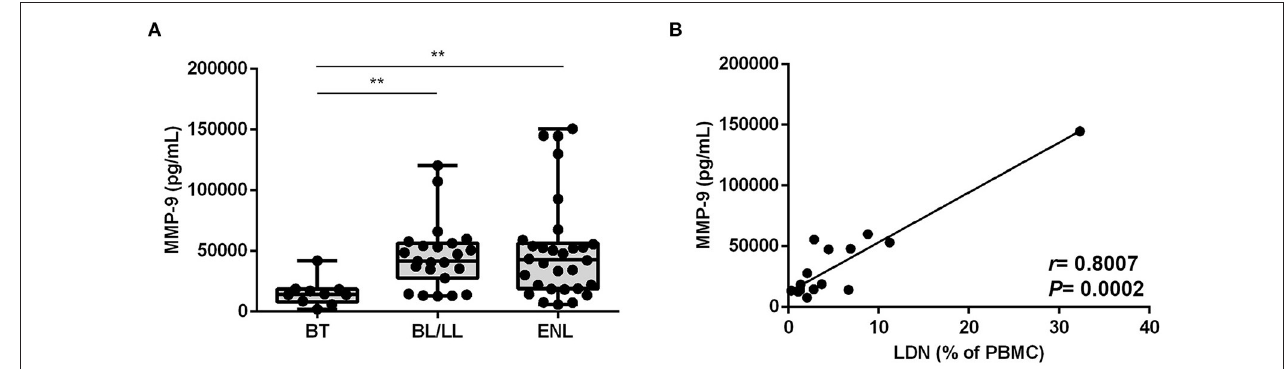
FIGURE 6 | MMP-9 degranulation correlates with the frequency of LDNs in BL/LL and ENL patients. (A) MMP-9 concentration was evaluated by enzyme-linked immunosorbent assay (ELISA) in the sera of 10 BT, 24 BL/LL, and 31 ENL patients. Box plots show median; interquartile range; and sample minimum and maximum. Dots represent individual patients. (B) Correlation between MMP-9 serum levels and frequency of circulating LDNs on BL/LL patients with or without ENL ( n = 17). Statistic: (A) Kruskal–Wallis with Dunn’s post-test and (B) Spearman’s rank correlation coefficient (R). ** p < 0.01.